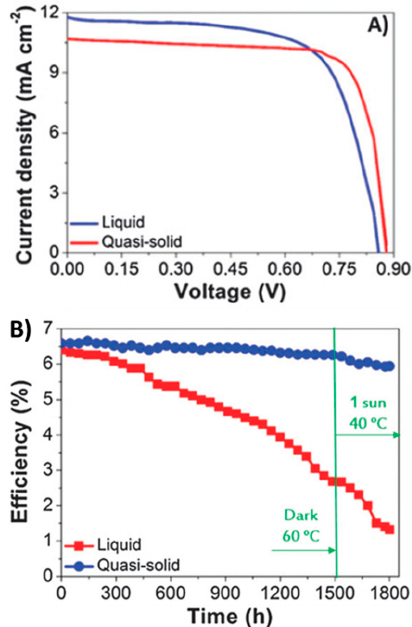
Figure 7. ( A ) J ‐ V curves under one sun for DSCs assembled with Co(II)/Co(III) complex ‐ based liquid or polymer electrolytes; ( B ) long ‐ term stability of the same DSCs: 60 °C under dark conditions in the initial 1500 h and 40 °C at one sun without a UV filter from 1500 to 1800 h. Adapted and reprinted with permission from